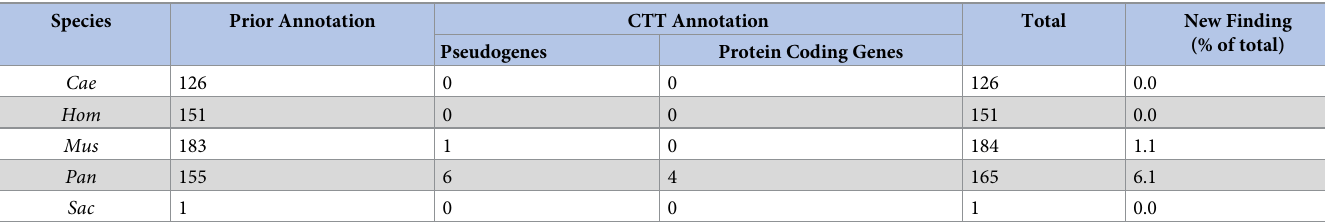
Table 6. CTT annotation of BTB genes in 5 non-plant